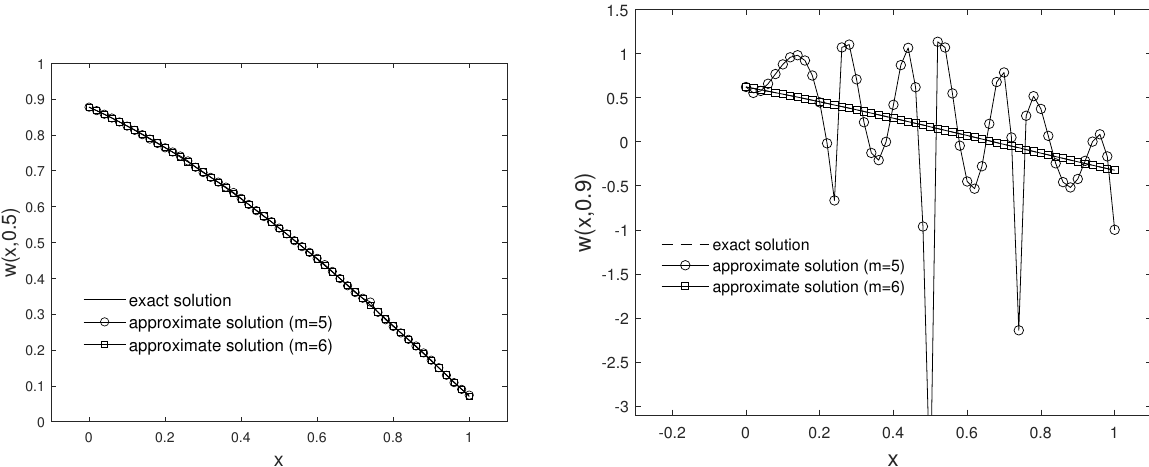
Figure 3. Plot of exact and approximate solutions at time t = 0.5 and t = 0.9 taking θ = 0, r = 5, J = 2 and δ t = ( 0.1 ) /2 m for Example 1.